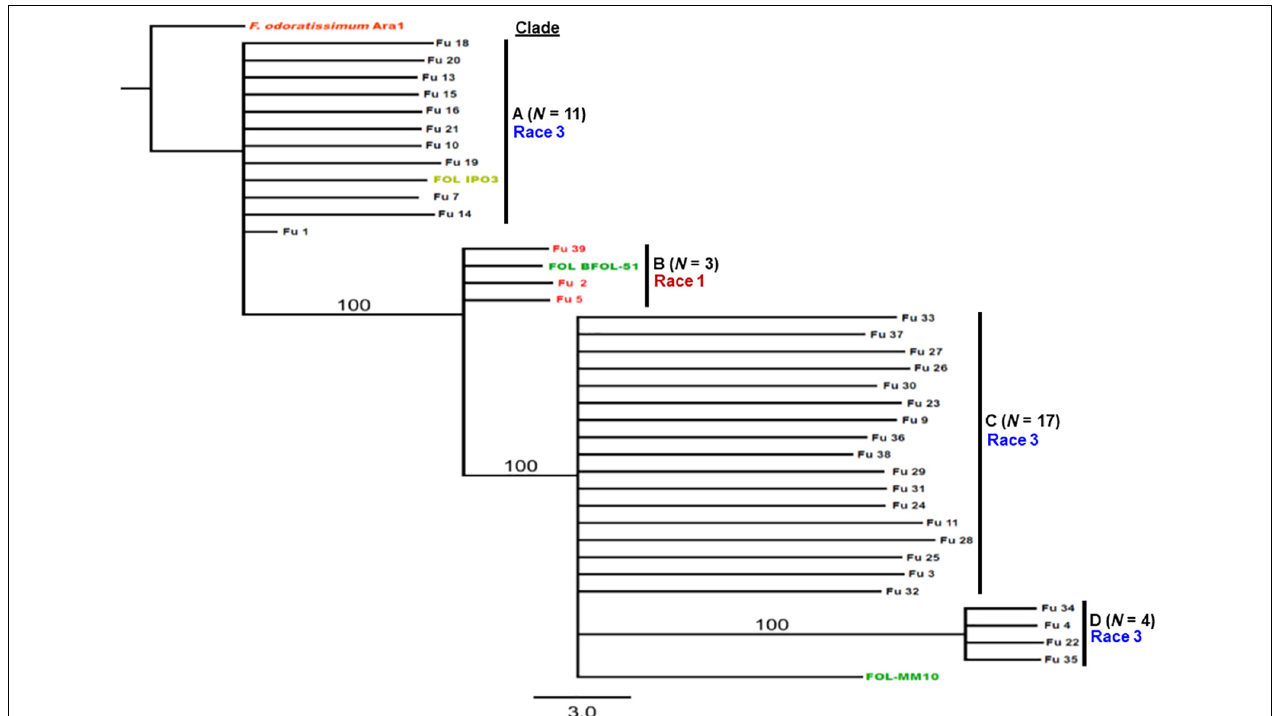
FIGURE 6 | Differentiation of Fusarium oxysporum f. sp. lycopersici race 3 from race 1 isolates collected from tomato-grown in greenhouses in North Carolina by polymerase chain reaction (PCR) assay targeting the SIX3 gene and sequence alignments. The Maximum-likelihood phylogenetic trees were generated from the SIX3 gene sequences of the representative isolates and outgroup isolate “Ara1” of F. odoratissimum sequences were downloaded from the National Center for Biotechnology Information database GenBank (http://www.ncbi.nlm.nih.gov/genbank). The tree topology was obtained through maximum-likelihood with 1,000 replications using the Tamura-Nei DNA substitution model. Parsimony bootstrap values ( > 80%) are shown above the branches. The clade of each isolate is also presented in Table 1 . Sequences of two isolates Fu 12 and Fu 17 were not included due to short lengths. Nonpathogenic isolate Fu 6 did not have an amplicon corresponding to the SIX3